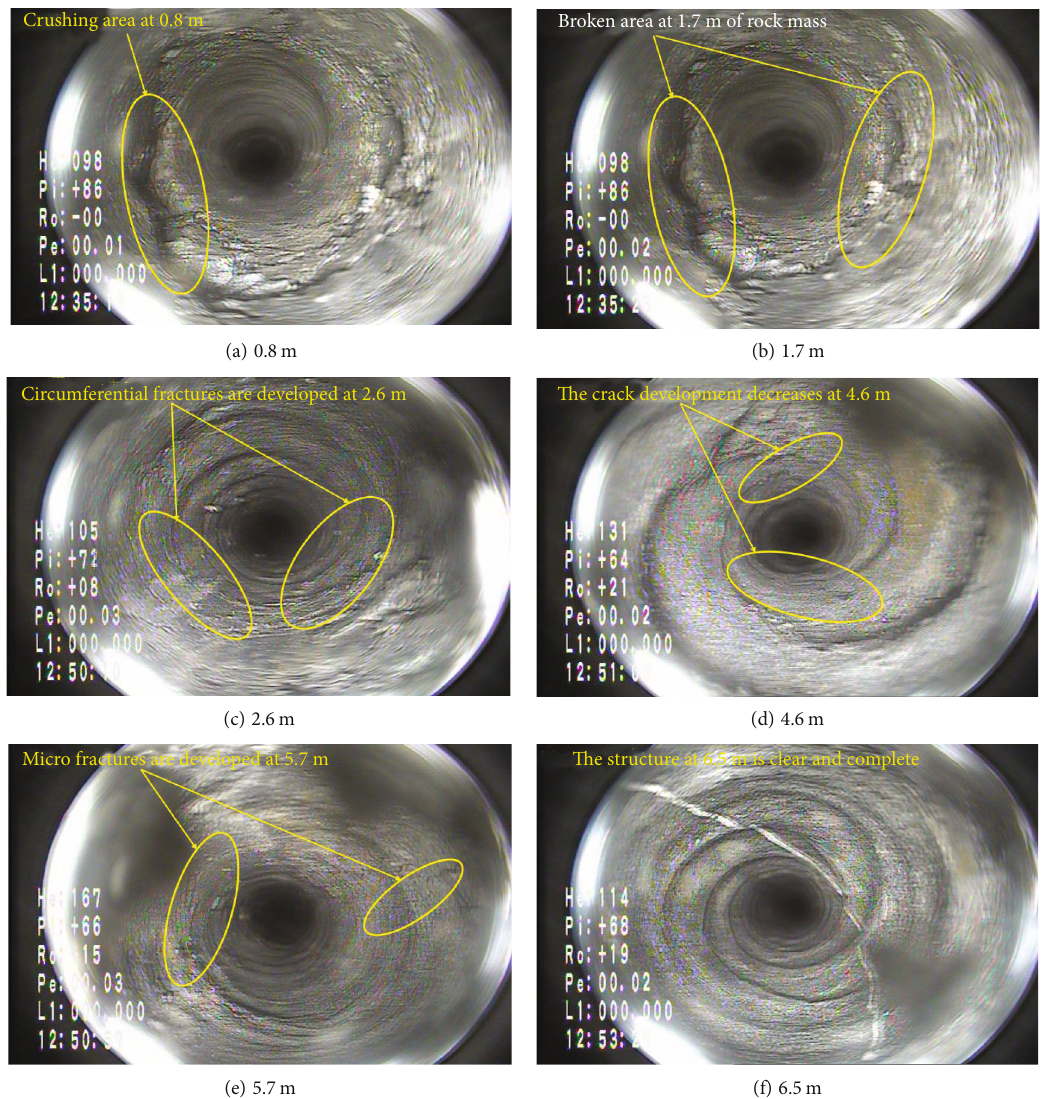
Figure 3: Peering image of the vertical roof borehole near the abandoned roadway side.